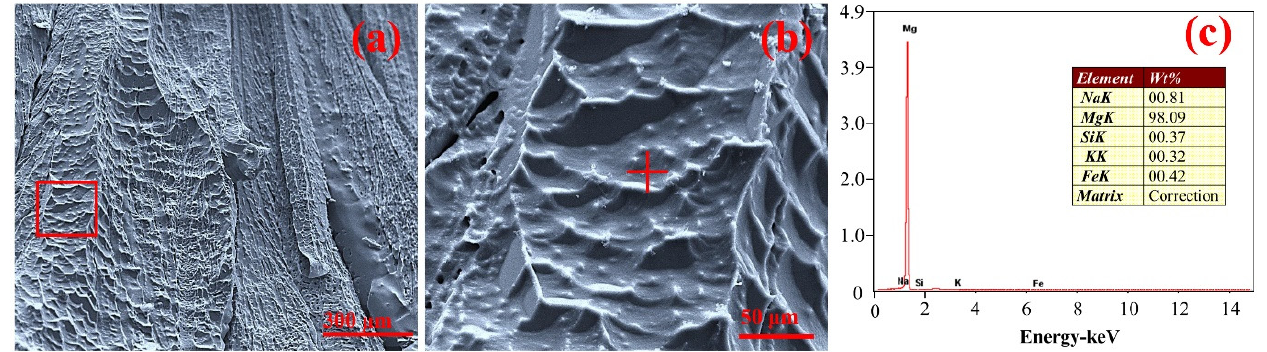
Figure 13. ( a , b ) Micromorphology of crystalline magnesium. ( c ) Energy spectrum analysis of crystalline magnesium.